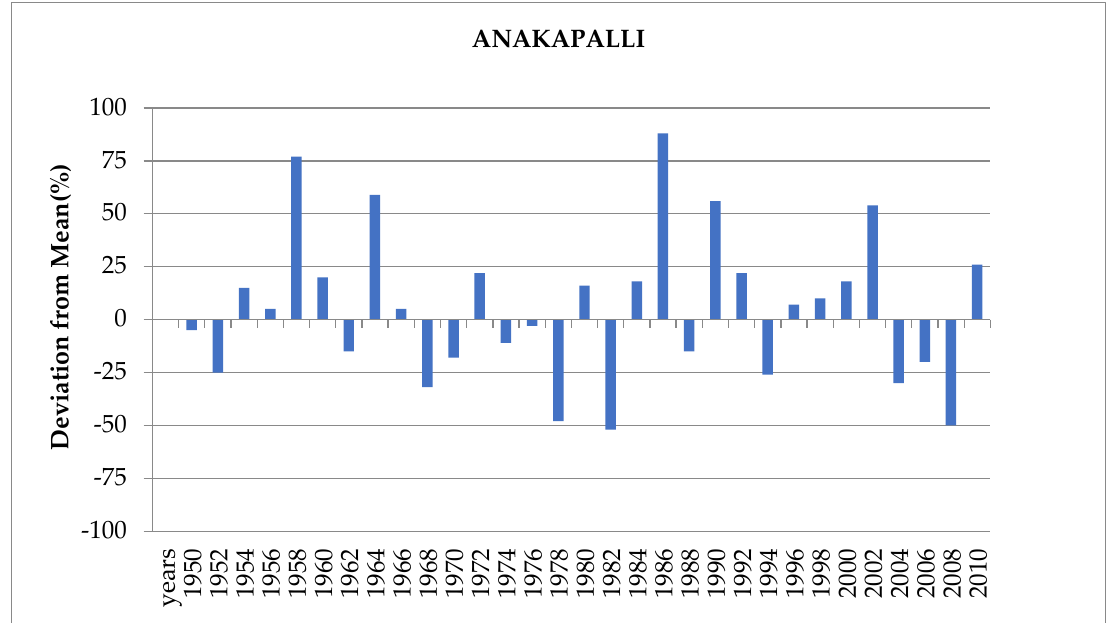
Figure 10. Anakapalli. Figure 10.